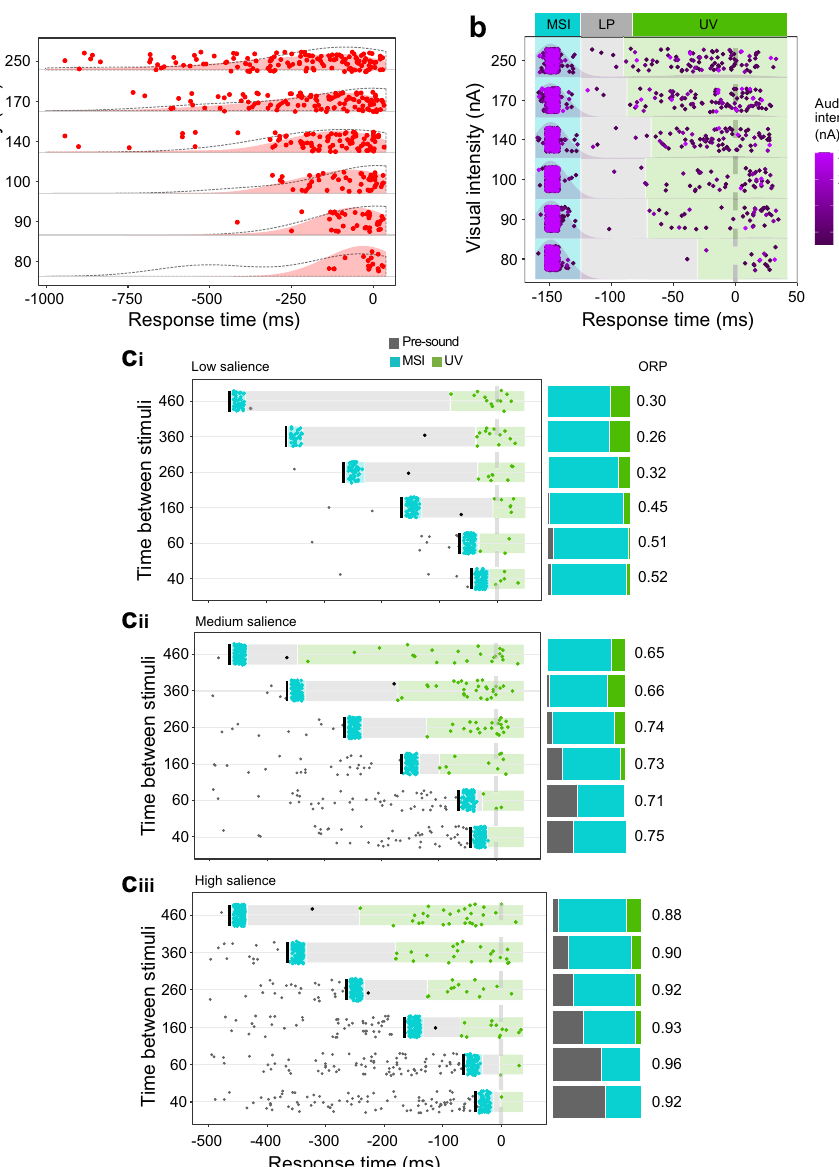
Figure 6. Model reproduces empirical response time distribution. ( a ) Response times and overlaid density distribution (light red) for visual unisensory trials, grouped by visual intensity. The grey dotted line is the experimental density distribution shown for comparison (cf. Figure 3e). ( b ) Multisensory response times and overlaid density distribution, grouped by visual intensity. The color of each dot represents auditory intensity. The vertical dotted line represents the end of visual stimulation. Responses are distributed in three distinct periods as in Fig. 4c–d (n = 5089). The boundary between LP and UV intervals is set by 5 and 95% of the responses. ( c ) Response times for multisensory trials with variable delay in ms between the auditory stimulus and the end of visual stimulus for low ( c i ) medium ( c ii ) or high ( c iii ) salience. Black vertical segments represent the time of auditory stimulus presentation (n = 845). Stacked bars to the right show response probability before the auditory stimulus (dark grey), MSI (cyan) and UV (green) for each delay. Numbers to the right indicate overall observed response probability for the simulation (ORP). Simulation was ran 100 times for each